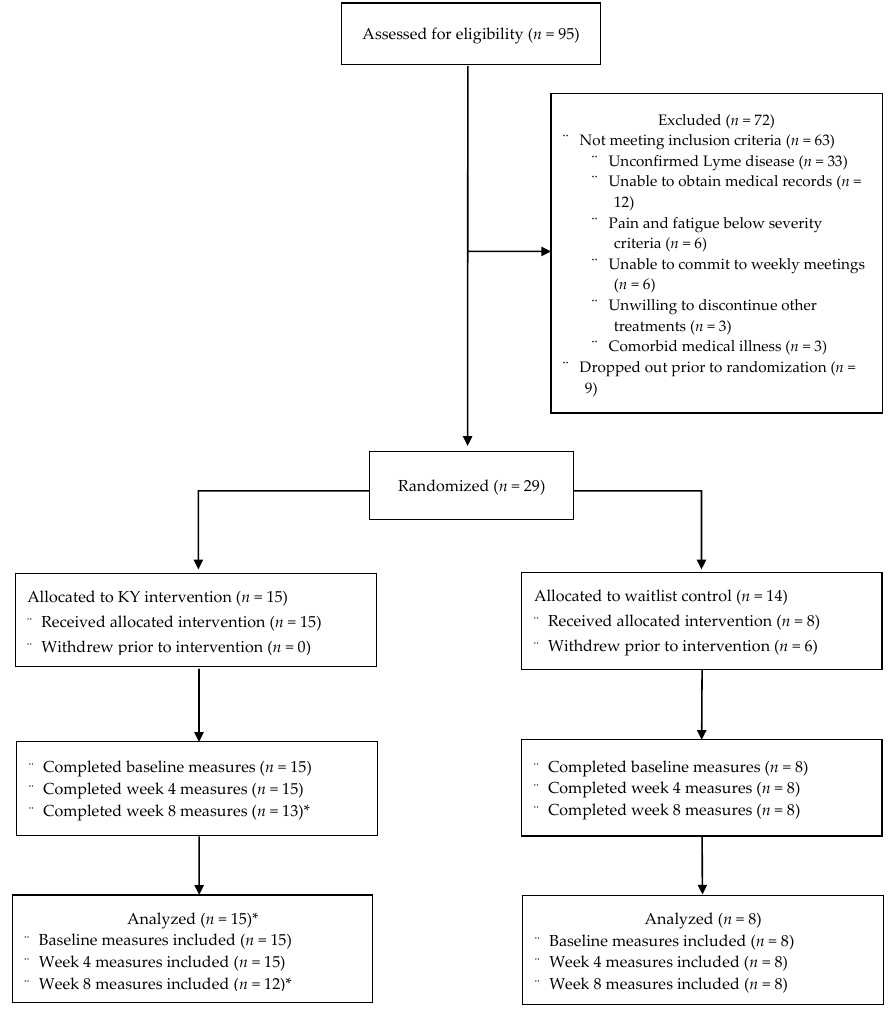
Figure 1. CONSORT flow diagram . Table 1. Demographics and clinical characteristics of participants who received allocated intervention.